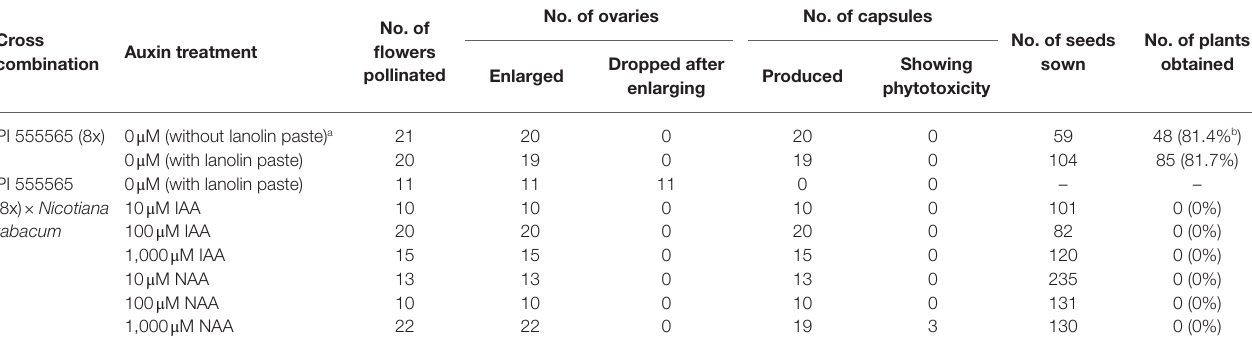
TABLE 1 | Effect of auxin treatment on ovary abscission and seed viability in the cross between Nicotiana suaveolens PI 555565 (8x) and Nicotiana tabacum . Cross Auxin treatment combination